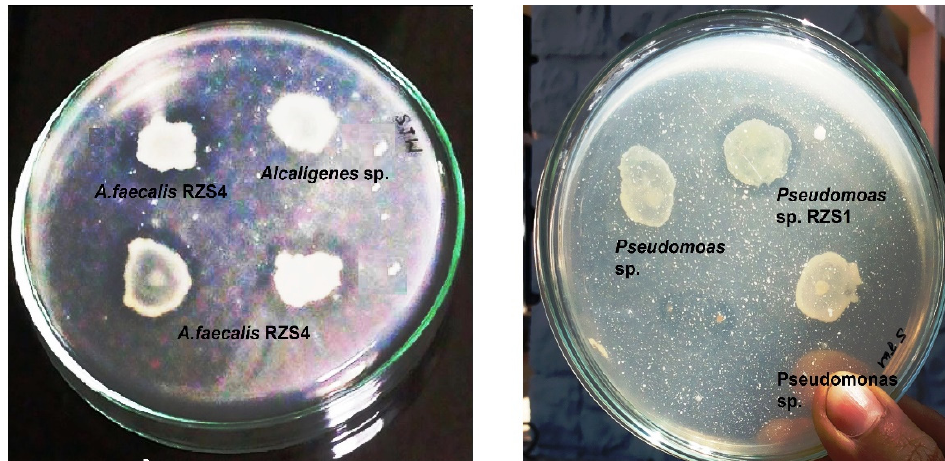
Figure 7. Biodegradation of PHB extracts of A. faecalis RZS4 and Pseudomonas sp. on MM having PHB extract (as the sole source of carbon grown) during 48 h incubation at 30 °C showing a zone of PHB hydrolysis around the colony